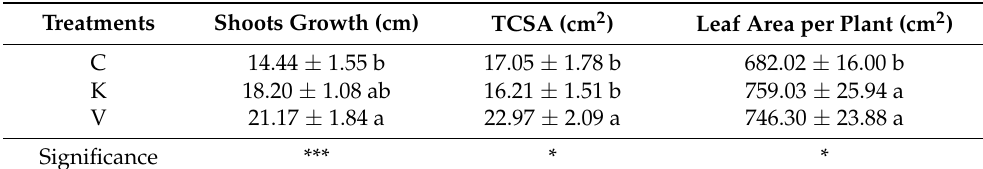
Table 1. Effect of kaolin (K) and di-1-p-menthene (V) on shoots growth, trunk cross sectional area (TCSA) and leaf area per plant at the end of growing season. C: control.